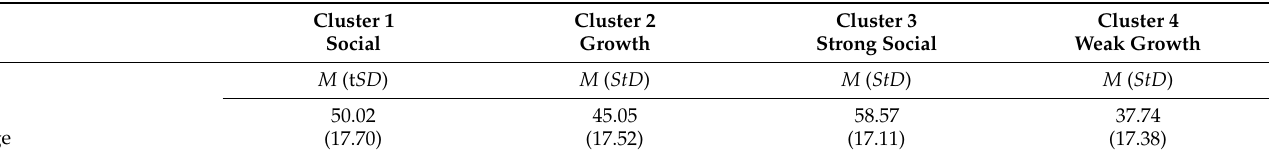
Table 5. Clusters’ sociodemographic information: Mean ( M ), standard deviation ( StD ), and frequency distributions (%), and one-way ANOVA tests results and chi-square tests